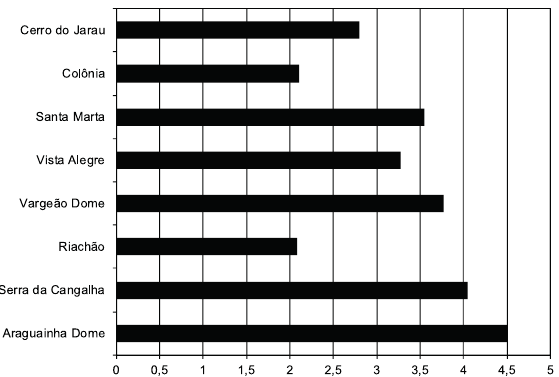
figure 3 - Graphical representation of the scientifi c value of impact structures in